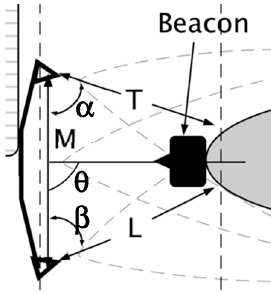
Figure 6. Nomenclature used for the algorithm. M is the distance between the front and back sensors. T and L are distances from the sensors to the AP side. α and β are angles formed between M and T or L and θ is the angle formed between M and the tether distance.